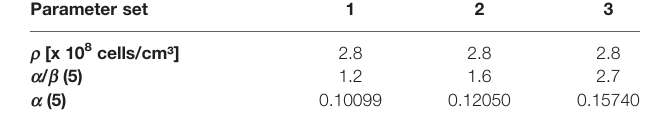
TABLE 2 | TCP model parameter sets for the robustness analysis. Parameter